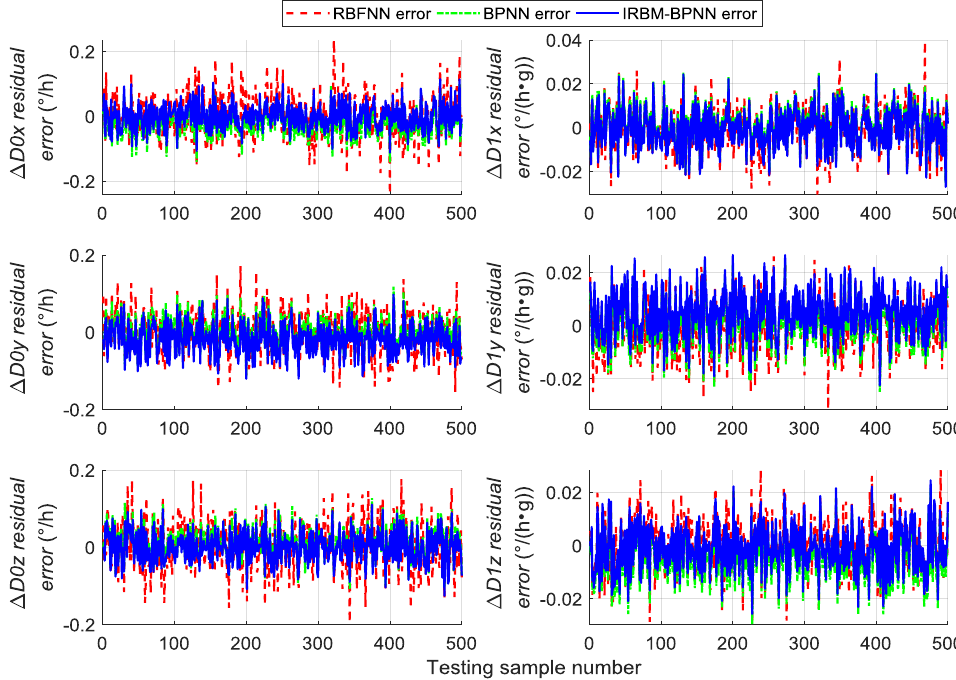
Figure 13. Contrast results of initial alignment residual error using three methods.